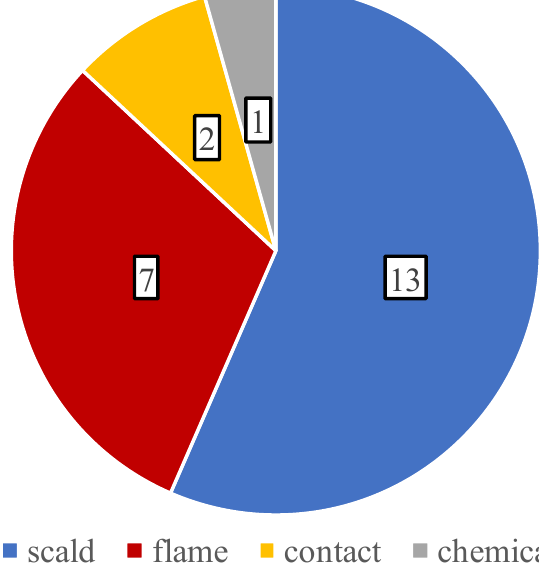
Figure 3. A pie chart showing the distribution of various burn etiologies. Four children had predominantly I-degree burns, while three patients had II/2-degree thermal injuries, in addition to their II/1-degree burns. Figure 4 shows the distribution of the burned facial areas with a mean of 3% TBSA (SD: 1.0; range: 1 – 5% TBSA).